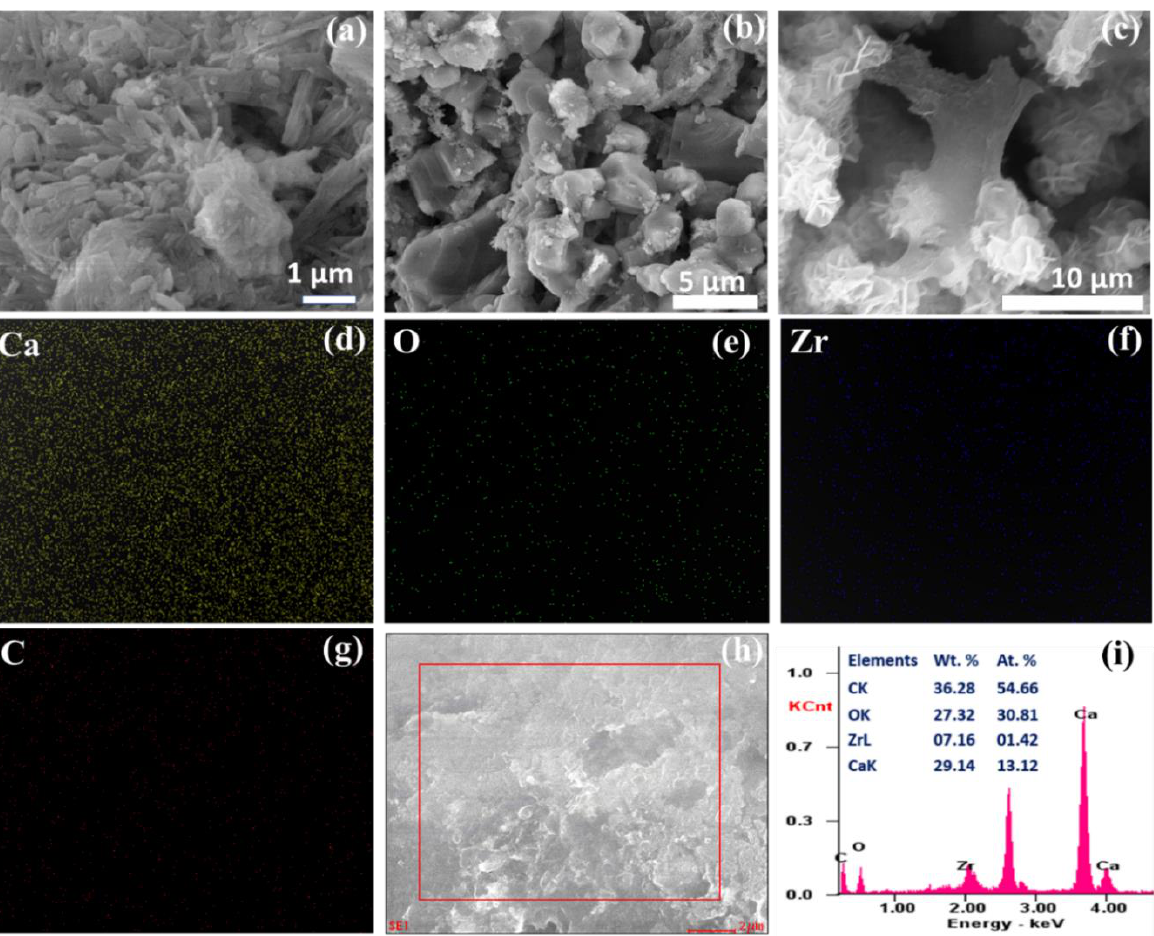
Figure 5. Representative SEM micrographs of CaO−ZrO 2 ( a – c ), elemental mapping of Ca ( d ), O ( e ), Zr ( f ), C ( g ) and EDS ( h , i ).